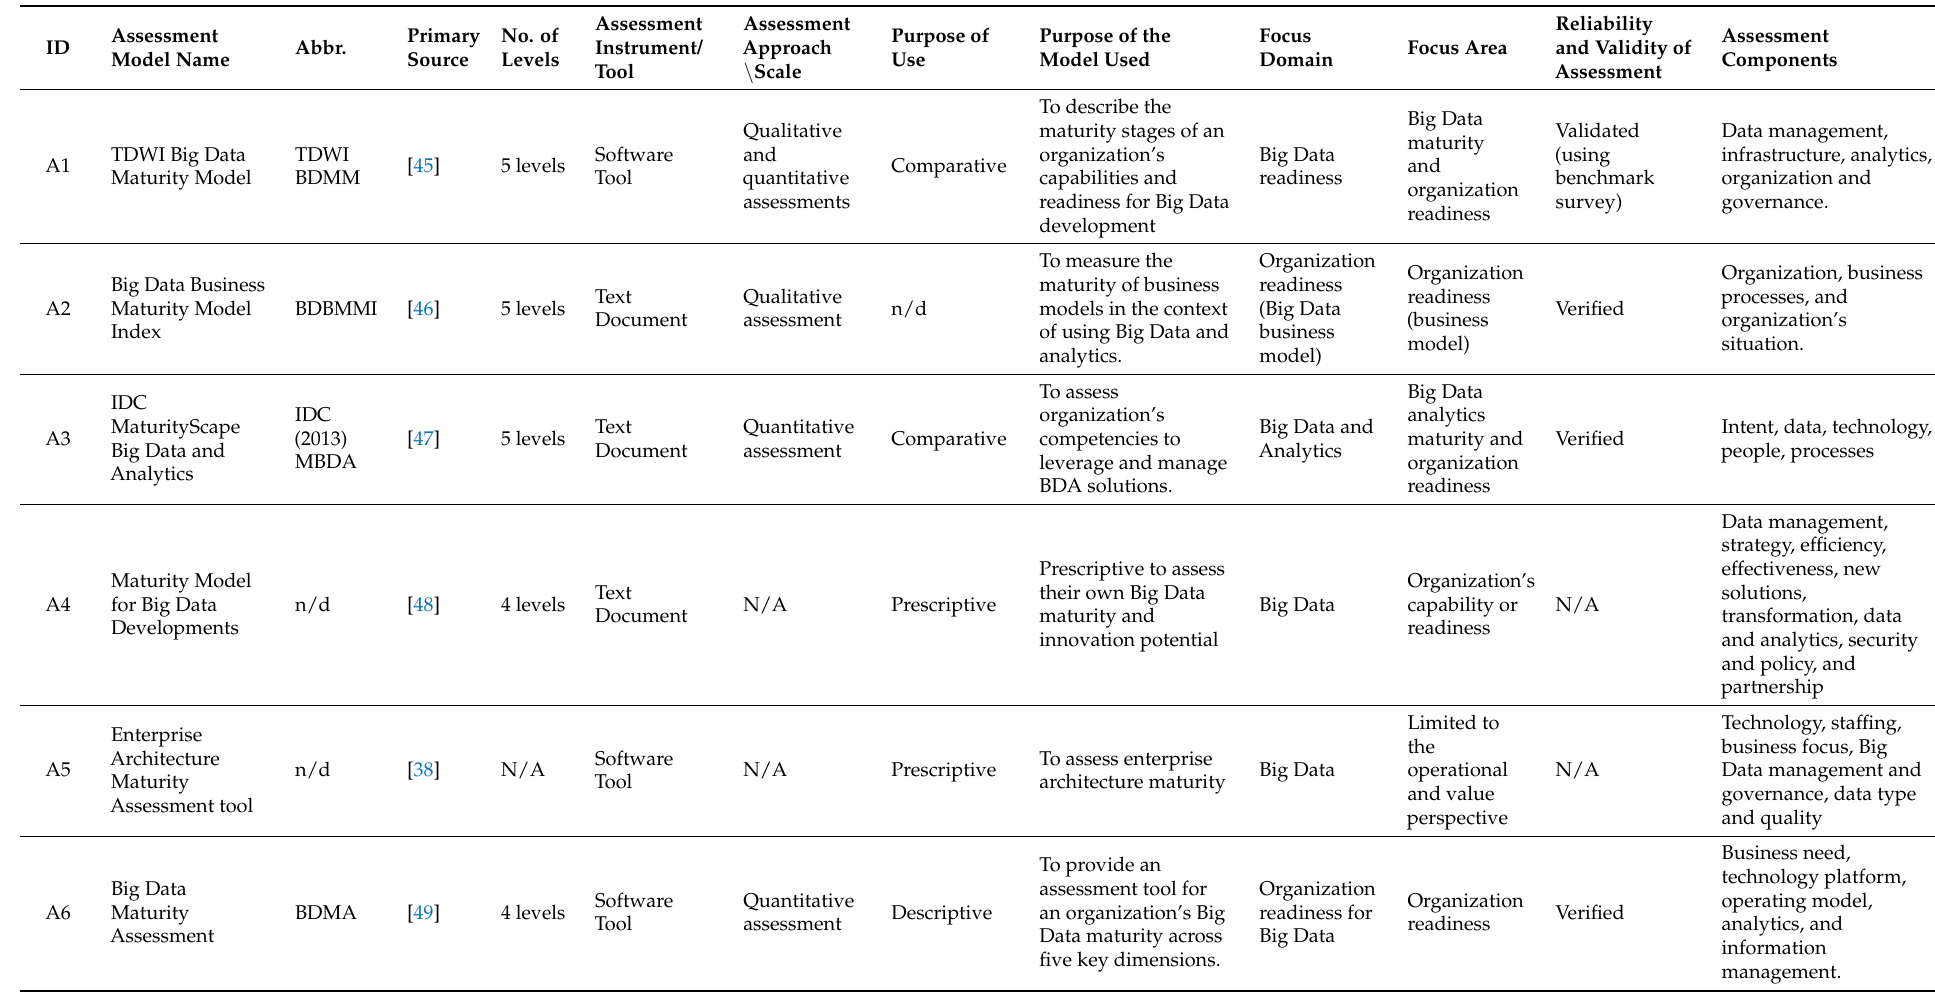
Table 7. The current Big Data maturity